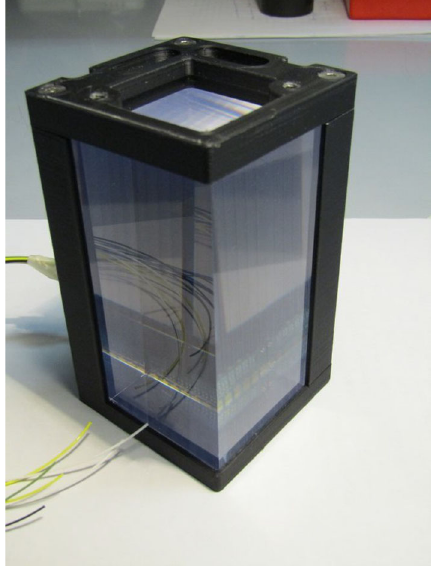
Fig. 19 Δ E-E telescope prototype